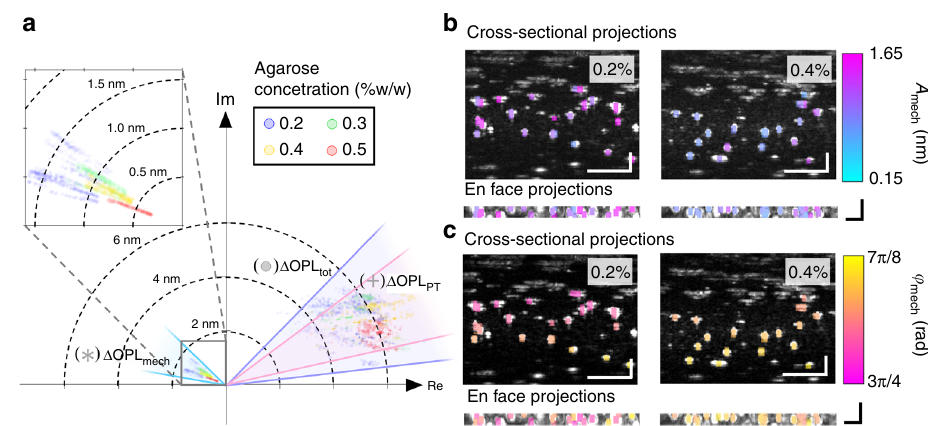
Fig. 4 PF-OCE measurements in four agarose hydrogel samples with different agarose concentrations. a All measurements of Δ OPL tot ( x b , y b , z b ) (circle), Δ OPL z fi tting, and Δ OPL x y z PT ( b ) (cross) after curve- mech ( b , b , b ) (star) displayed on the complex plane. b in 0.2 and 0.4% agarose samples displayed as a map overlaid on cross-sectional and en face OCT image maximum intensity projections (grayscale). c Corresponding maps of φ mech ( x b , y b , z b ) from the same datasets as in b . Scale bars: 50 μ m (white, cross-sectional projections) and 20 μ m (black, en face projections). See Fig. 5 for quantitative comparison to shear rheometry and Supplementary Fig. 10 for cross-sectional and en face projections of A mech ( x b , y z φ x y z b , b ) and mech ( b , b , b ) for all four agarose hydrogel